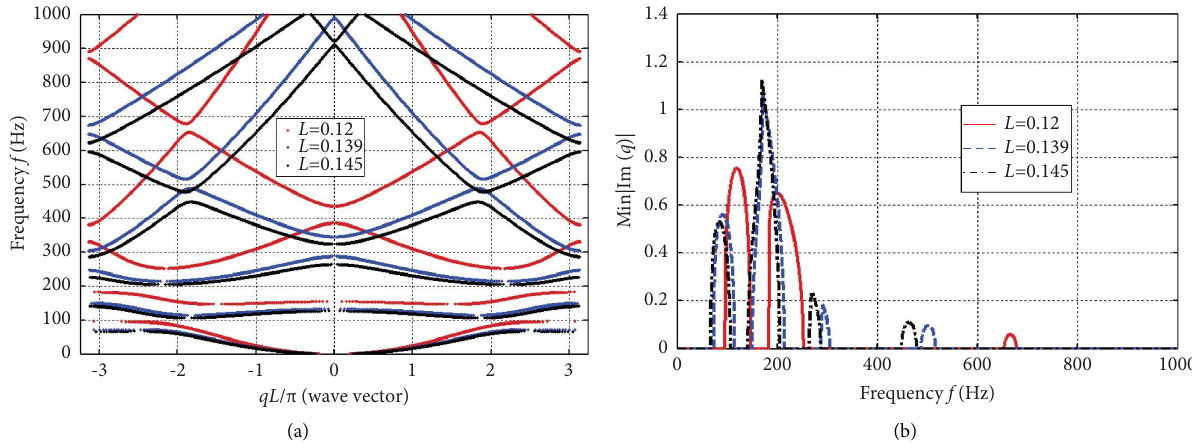
Figure 10: Efects of length L on bandgaps of the double-beam metamaterial: (a) efects of length L on bandgap structures and (b) efects of length L on attenuation